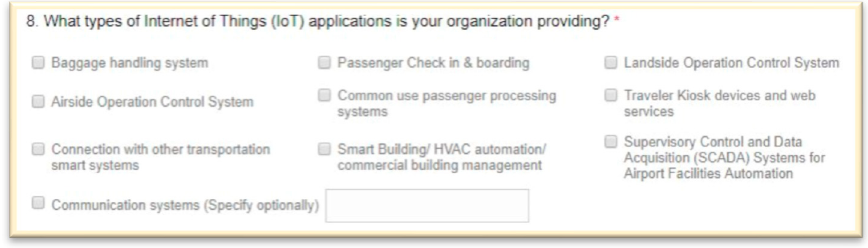
Figure A2. Questions for contact details.